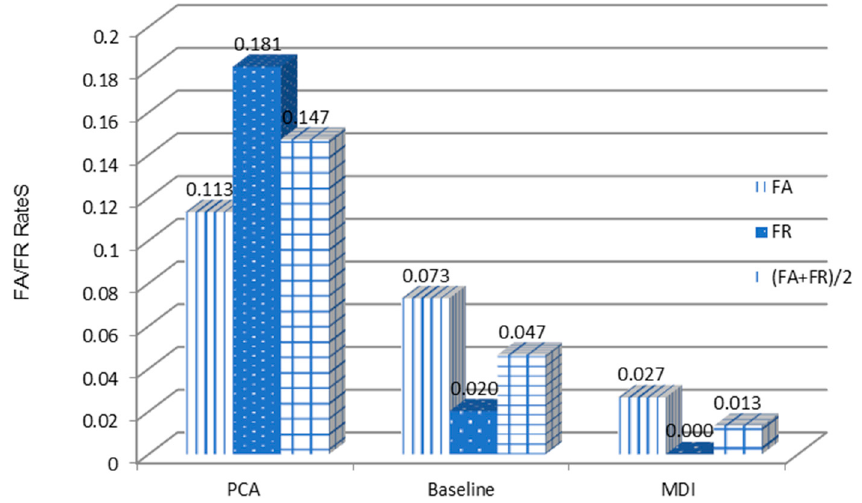
Figure 13. Multi-dimensional algorithm FA/FR comparison results.